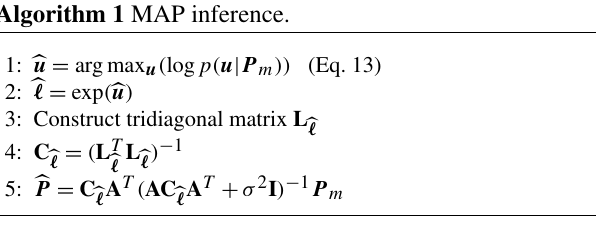
Algorithm 1 MAP